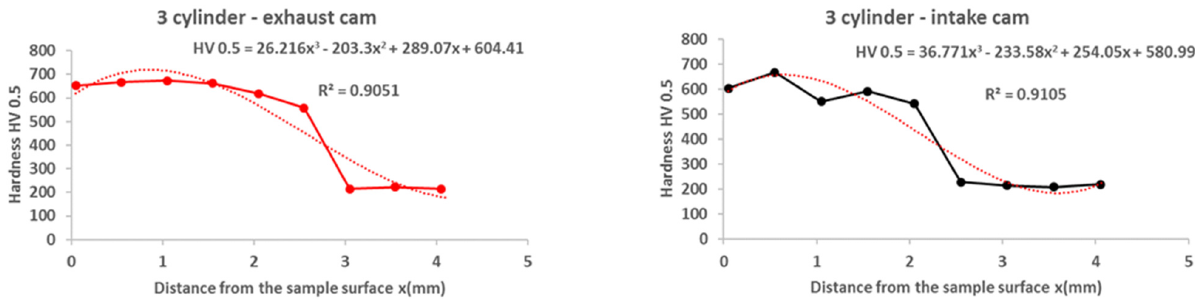
Figure 15. Regression analysis for a 3rd − order polynomial for the values of the 3rd cylinder on the exhaust and intake cams.